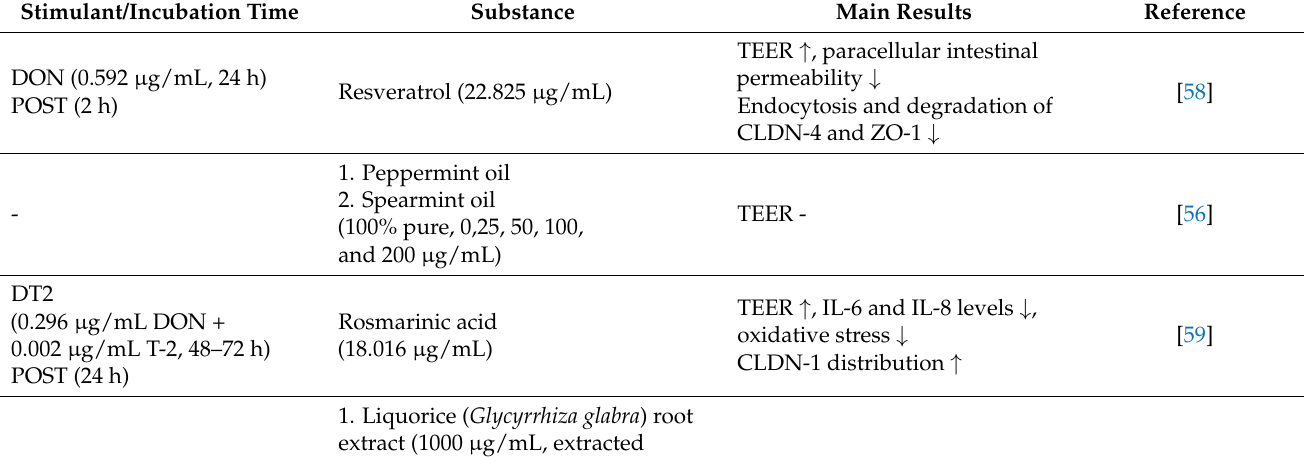
Table 1. Effects of PFA on barrier function of IPEC-J2